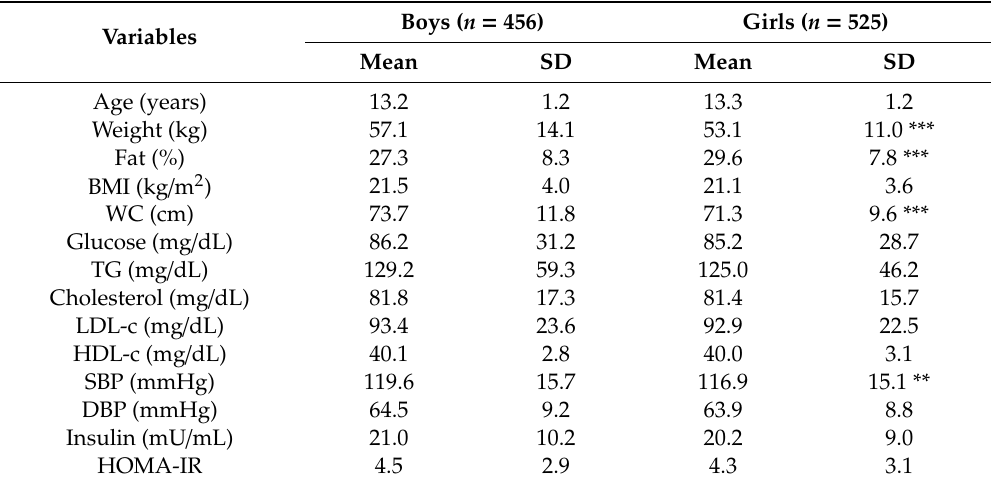
Table 2. Baseline characteristics of